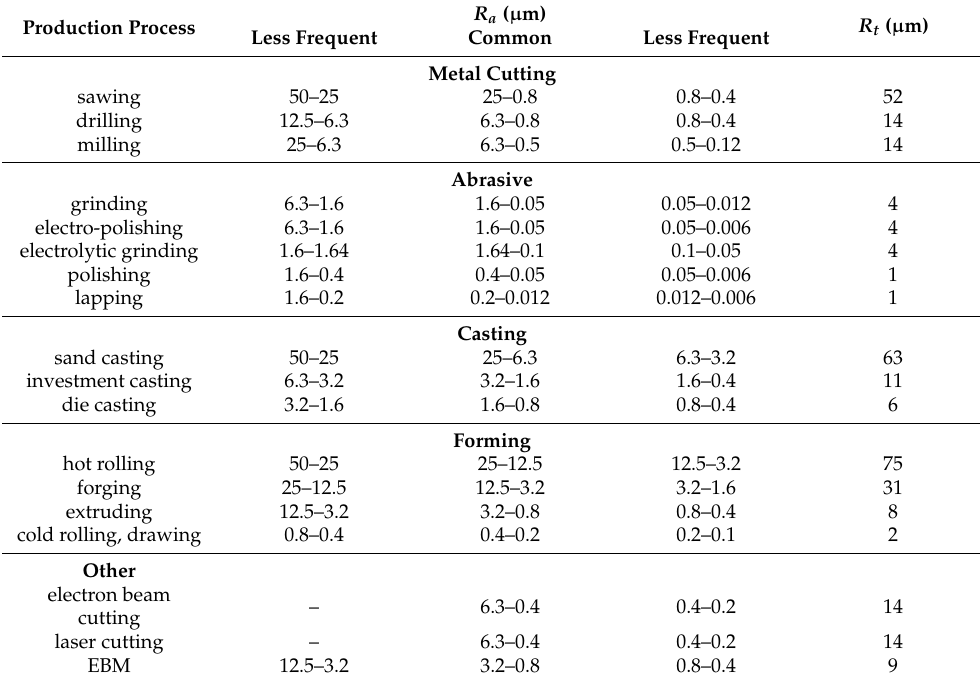
Table 1. Indicative values of mean( Ra ) and maximum ( Rt ) roughnessdue to different industrialprocesses. Production